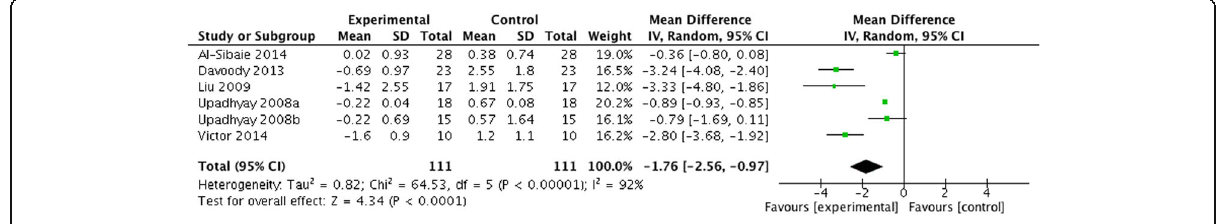
Fig. 4 Forest plot for anchorage loss in the vertical dimension